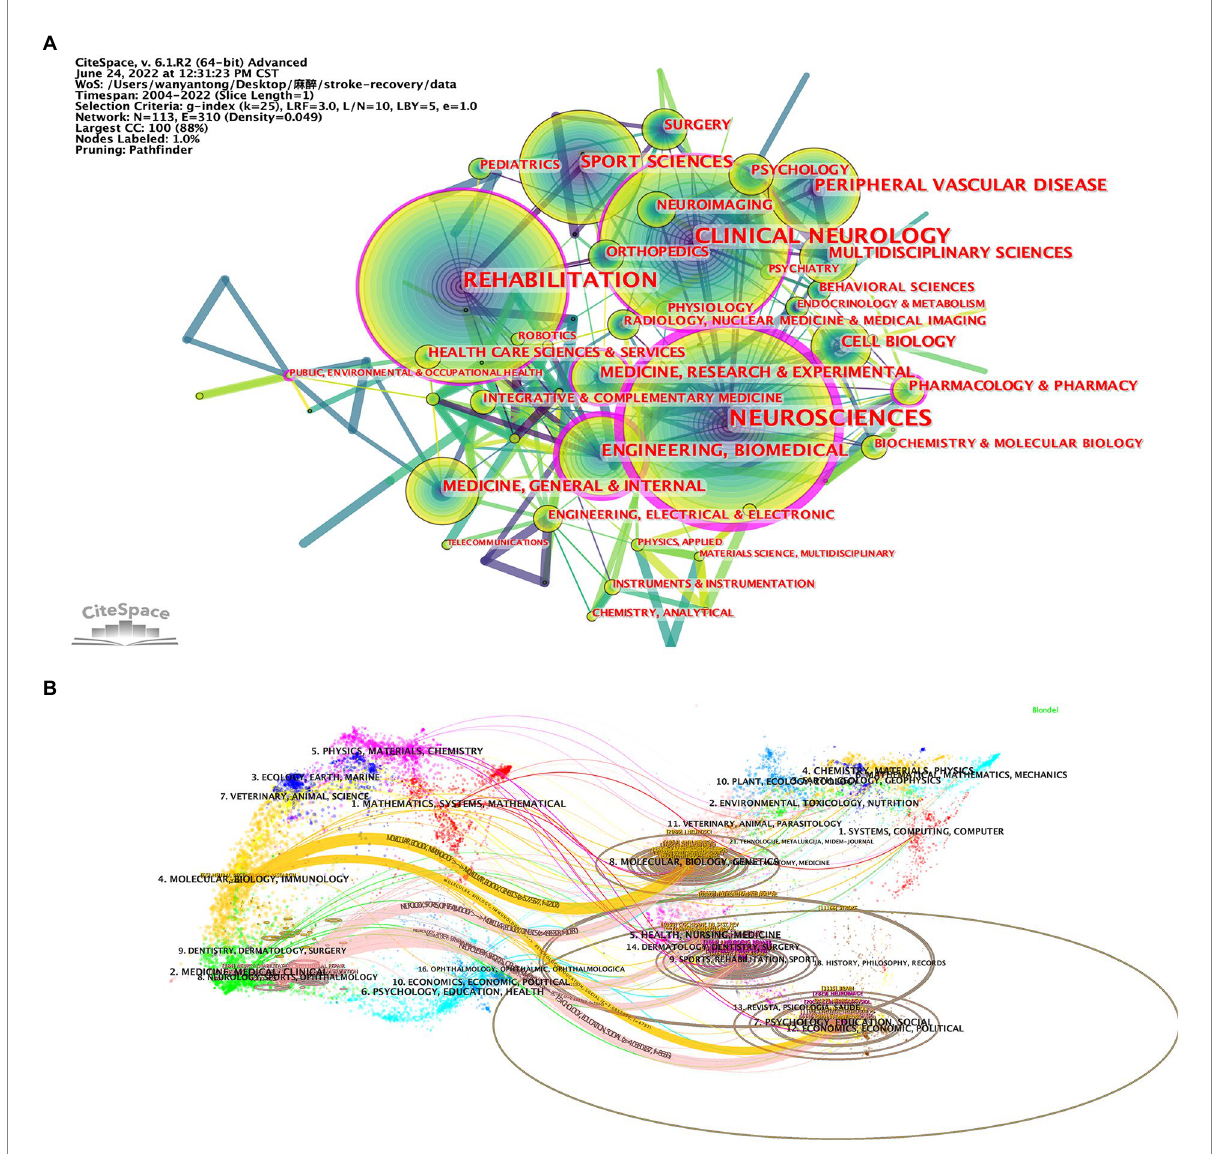
FIGURE 5 Category network map in the field of stroke motor function rehabilitation: (A) publication distribution among different categories; (B) dual-map overlay of journal publishing